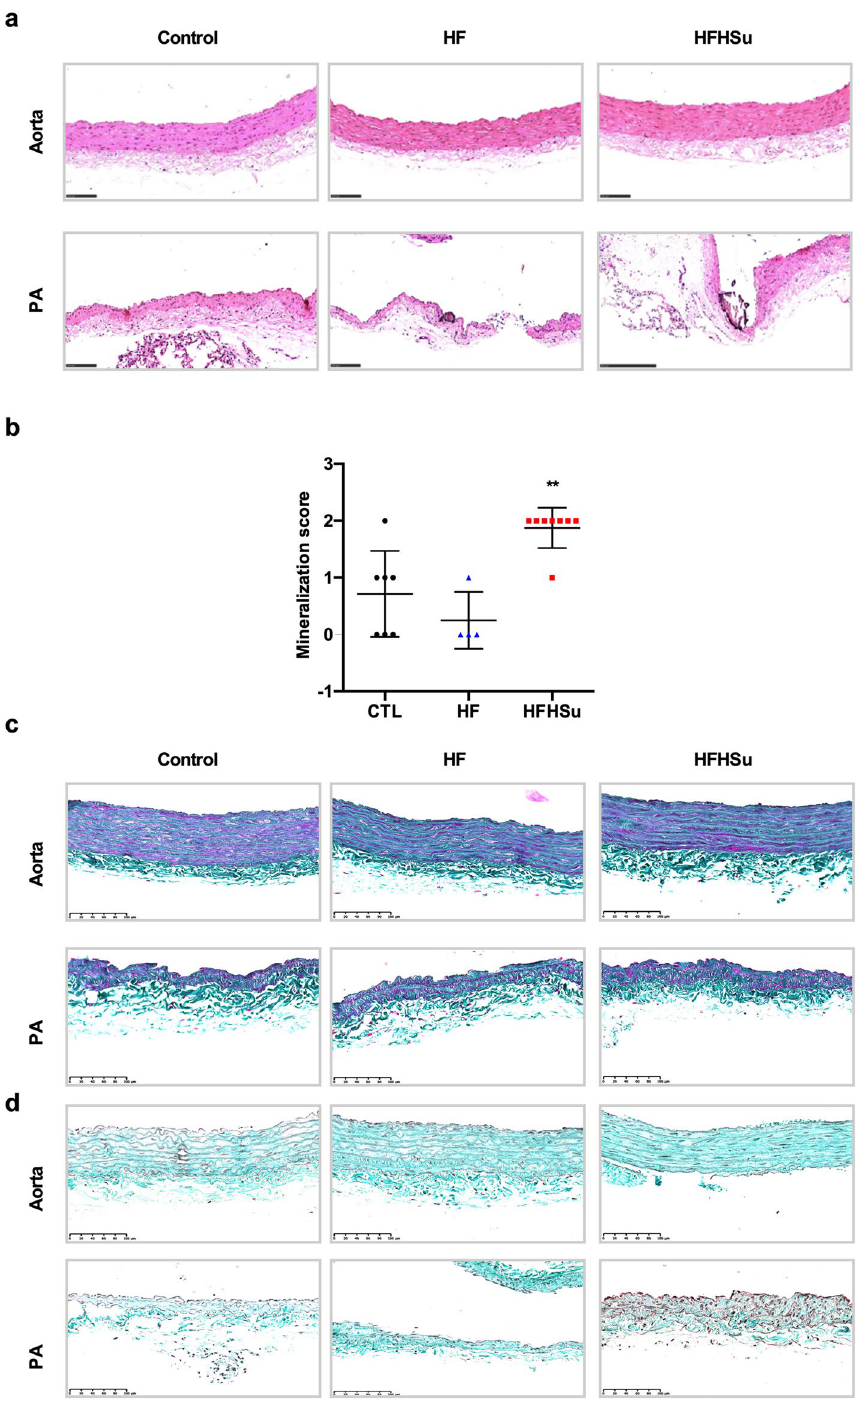
Figure 8. Effect of prediabetes and early phase type 2 diabetes on vascular mineralization. Histological analysis of the arteries stained with Hematoxylin and Eosin staining. No mineralization was observed on the aorta of the control, HF and HFHSu animals ( a , top panel; left to right images, respectively). Mineralization was observed in the PA of various control and HF animals and in the PA of all the HFHSu animals ( a , bottom panel; left to right images, respectively). ( b ) Vascular mineralization levels in PA of control (n = 7), HF (n = 4) and HFHSu (n = 8) animals. ( c ) Masson’s trichrome staining for collagen evaluation. No alterations were observed on collagen in the aorta of the control, HF and HFHSu animals (c, top panel; left to right images, respectively) nor in the PA of the control, HF and HFHSu animals (c, bottom panel; left to right images, respectively). ( d ) Taenzer-Unna Orcein staining for elastin evaluation. No alterations were observed on elastin in the aorta of the control, HF and HFHSu animals ( d , top panel; left to right images, respectively) nor in the PA of the control, HF and HFHSu animals ( d , bottom panel; left to right images, respectively). Values are presented as mean ± SD. One-way ANOVA with Dunnet’s comparison test. ** p < 0.01 versus control